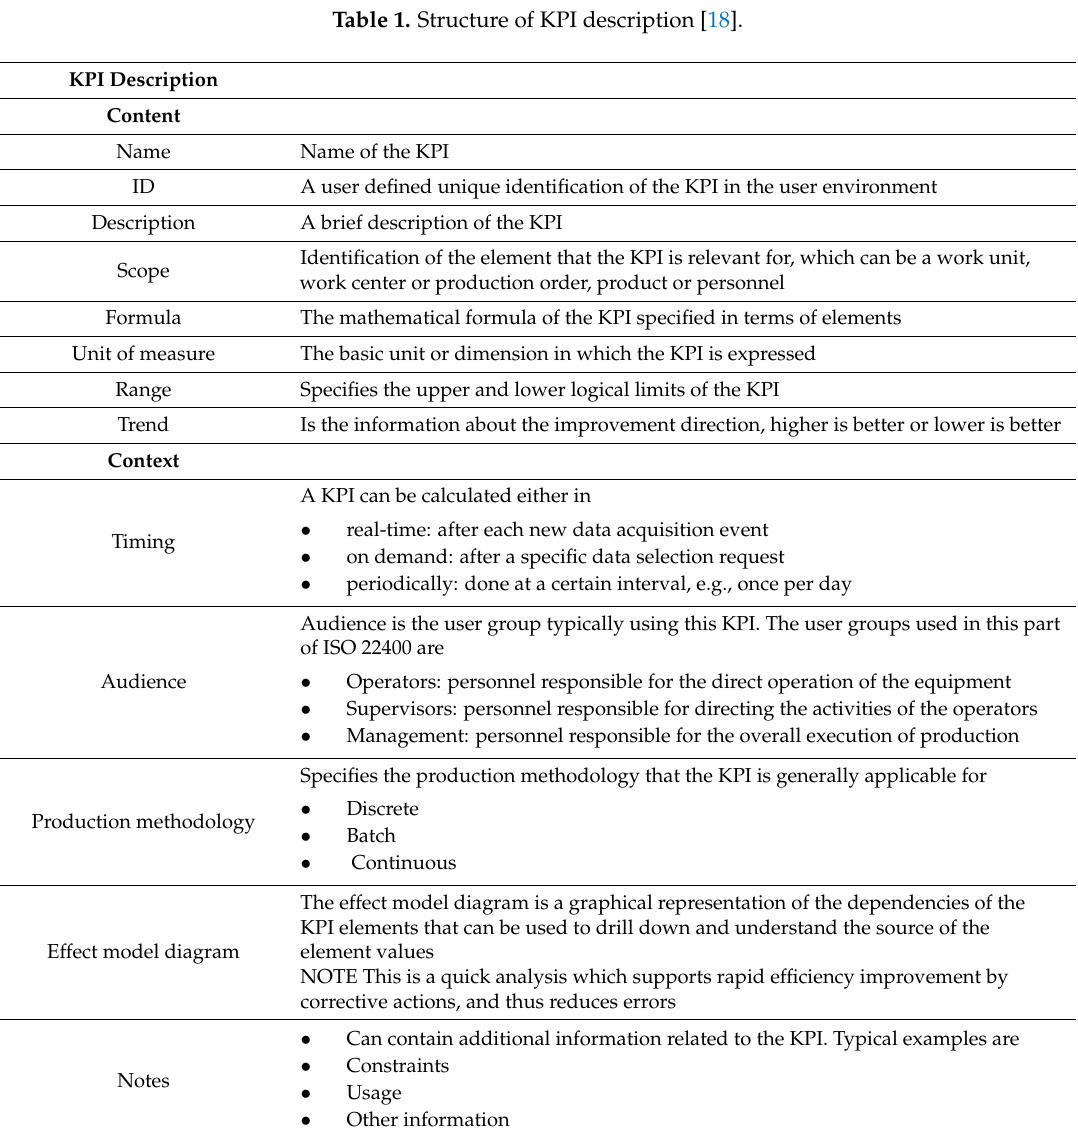
Table 1. Structure of KPI description